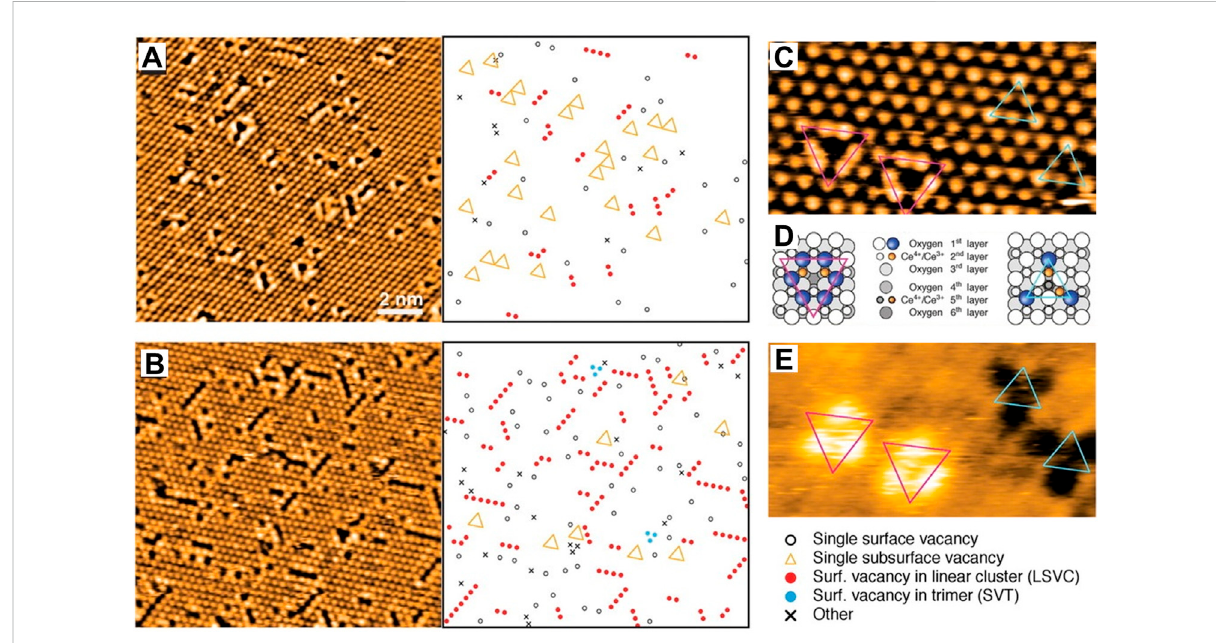
FIGURE 4 Defect formation on the CeO 2 (111) surface: (A,B) STM images of the CeO 2 (111) surface under different reduction degree and corresponding representationsoftheobserveddefects. (C – E) Filled-state (C) andempty-state (E) STMimagesofsingle vacancies, andrelatedstructuralmodels (D) (magenta triangles mean the surface vacancy and cyan triangles represent the subsurface vacancy). Reproduced with permission (Esch et al., 2005). Copyright 2005,